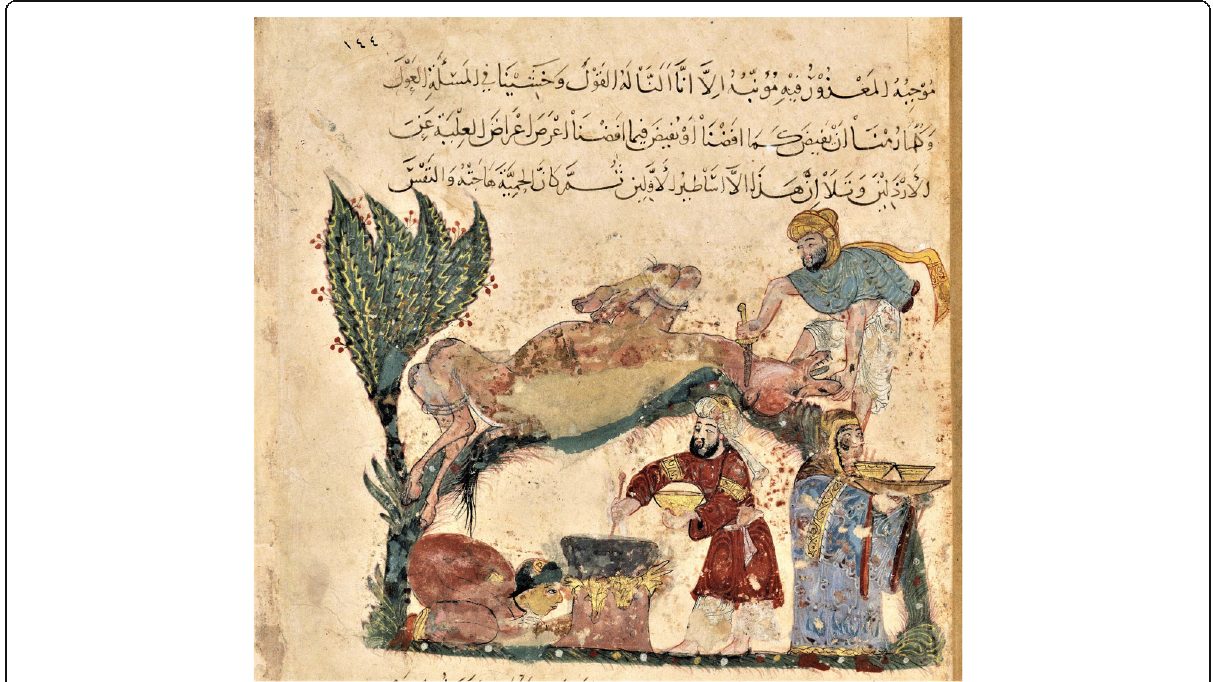
Fig. 11 A page from “ The Maqamat al Hariri ” date 1236-37A.D. showing the slaughtering of a dromedary by a cut in the throat area. This is